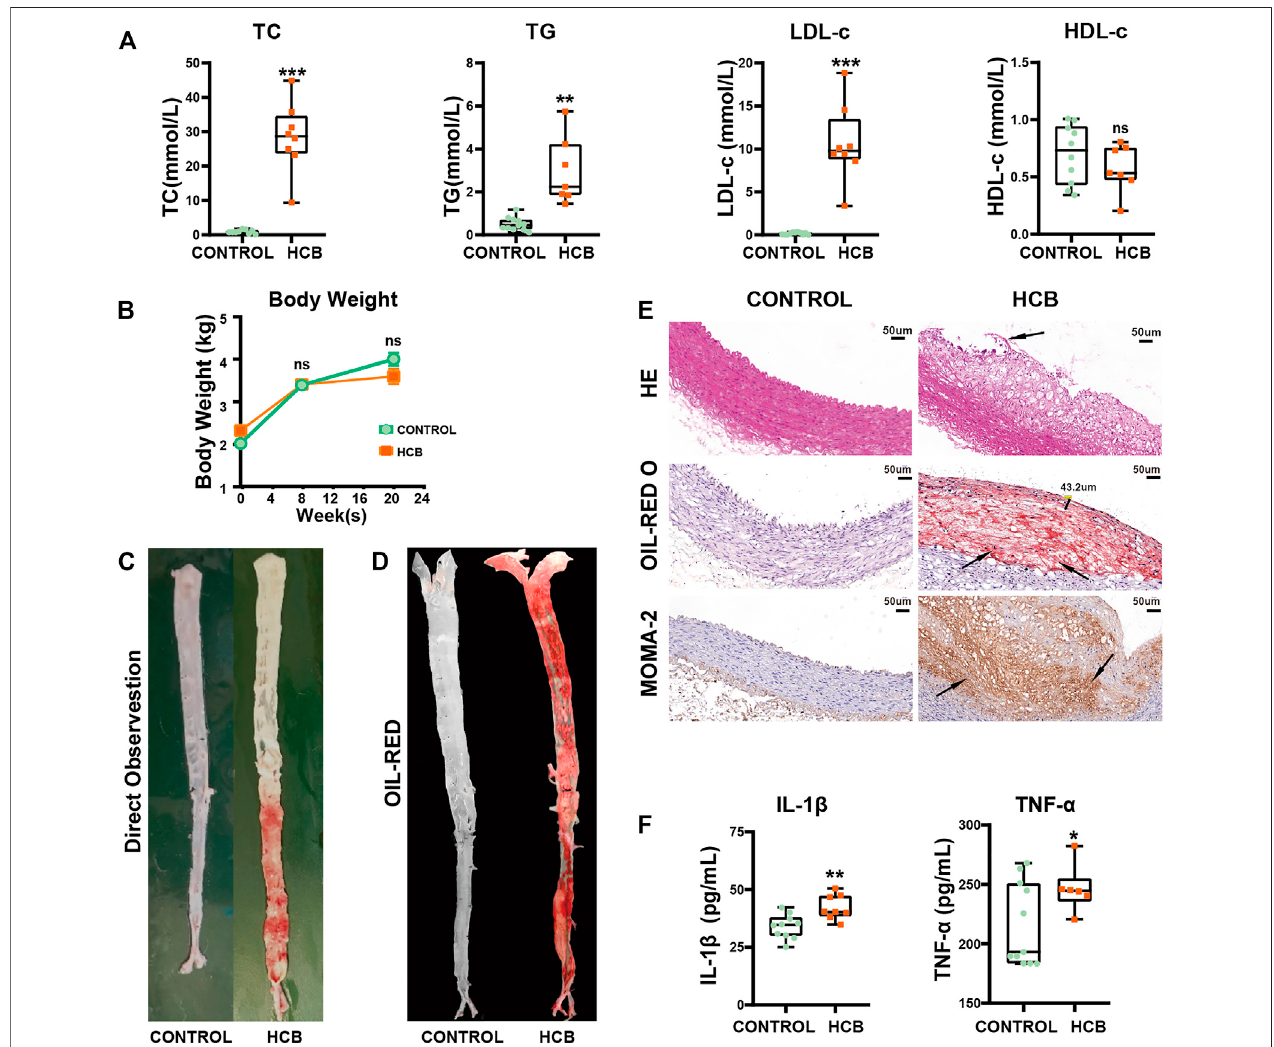
FIGURE 1 | HCB signi fi cantly promoted the formation of plaques and enhanced the level of in fl ammation. CONTROL: normal diet (n = 12); HCB: high cholesterol diet and balloon injury (n = 8); w: weeks (A) The changes of Blood lipids of New Zealand White Rabbits in HCB and CONTROL groups measured by enzymatic determination. (B) The changes in body weight of two groups (C,D) the formation of plaques in two groups. The general view directly (C) and Oil Red O staining of the entire aorta (D) in the CONTROL group (left) and HCB group (right). Oil red O (ORO) staining was applied to show lipid (E) = HE staining, Oil Red O staining and MOMA-2immunohistochemicalstainingofabdominalaorticcross-sections.Theblacklinesegmentmarked43.2 μ mrepresentsthemeasuredthicknessofthe fi bercap was 43.2 μ m. The area pointed by the black arrows represent ruptured plaques, lipid cores, and tan-stained macrophages. (F) The changes of IL-1 β and TNF- α of New Zealand White Rabbit in two groups measured by ELISA Kits. Data presented as median (minimum to maximum) (A, F), and the mean ± SEM (B). Non-parametric test was used for statistical tests in A, B and F. *: p < 0.05; **: p < 0.01, ***: p < 0.001.